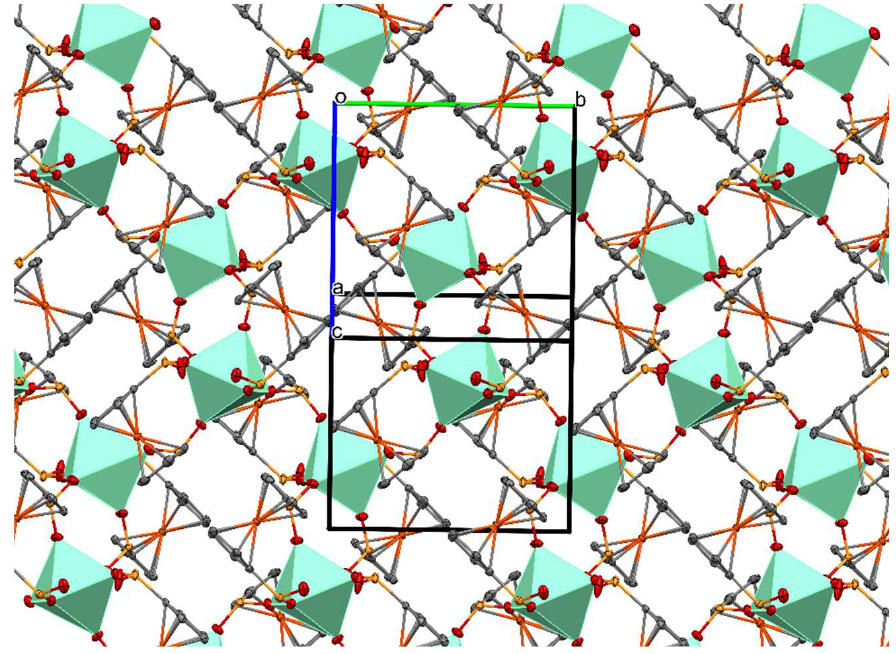
Figure 3. A 2D polymeric structure of 2 . Sm ions are shown as light-green octahedron. Hydrogen atoms are hidden for clarity.